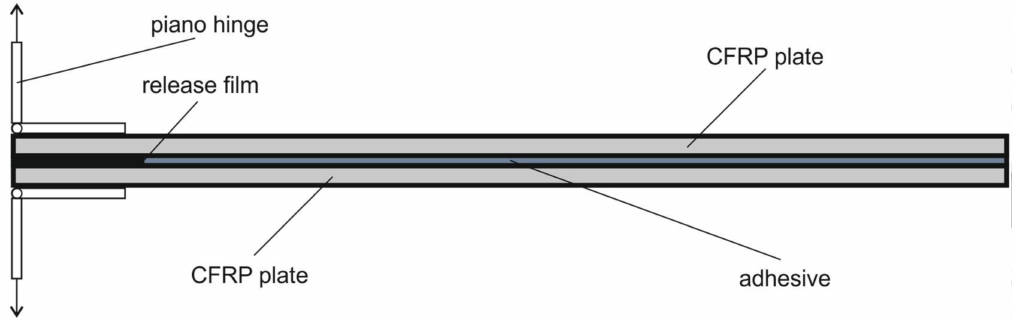
Figure 1. Schematic drawing of the mechanical test used for determining G IC values.